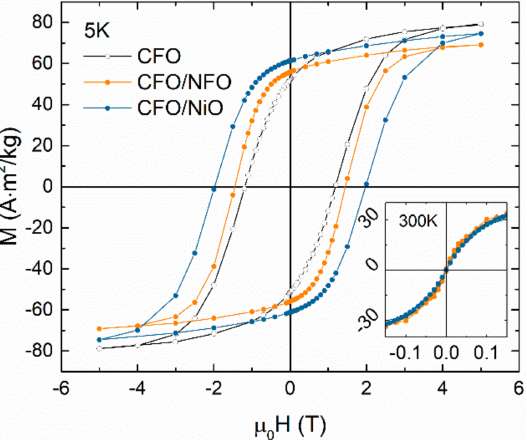
Figure 3. M-H hysteresis loop at 5 K for all samples. Inset shows low field region of M-H loops at 300